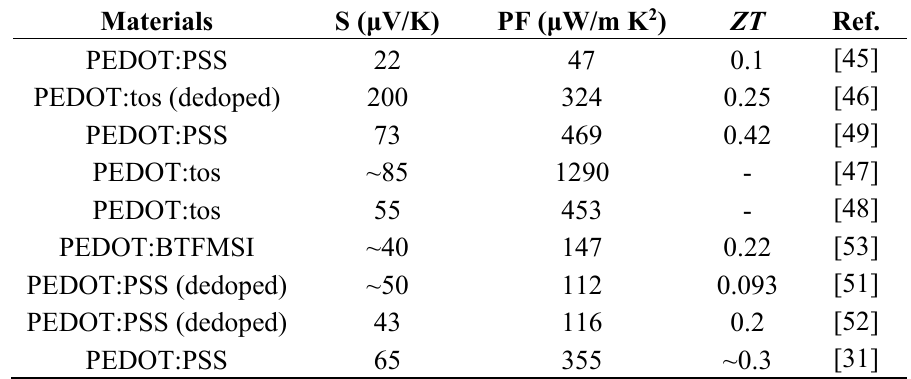
Figure 7. Seebeck coefficient measurements of PEDOT:PSS films at different humidity levels. Closed circles represent Seebeck coefficient measurements at a humidity of 30% and open circles represent Seebeck coefficient measurements at a humidity larger than 90%. Reproduced with permission from [31]. Copyright 2014 Japan Society of Applied Physics. Table 1. Thermoelectric (TE) properties of poly(3,4-ethylenedioxythiophene) (PEDOT)-based materials. (tos = tosylate, and PSS = poly(styrenesulfonate)). Materials